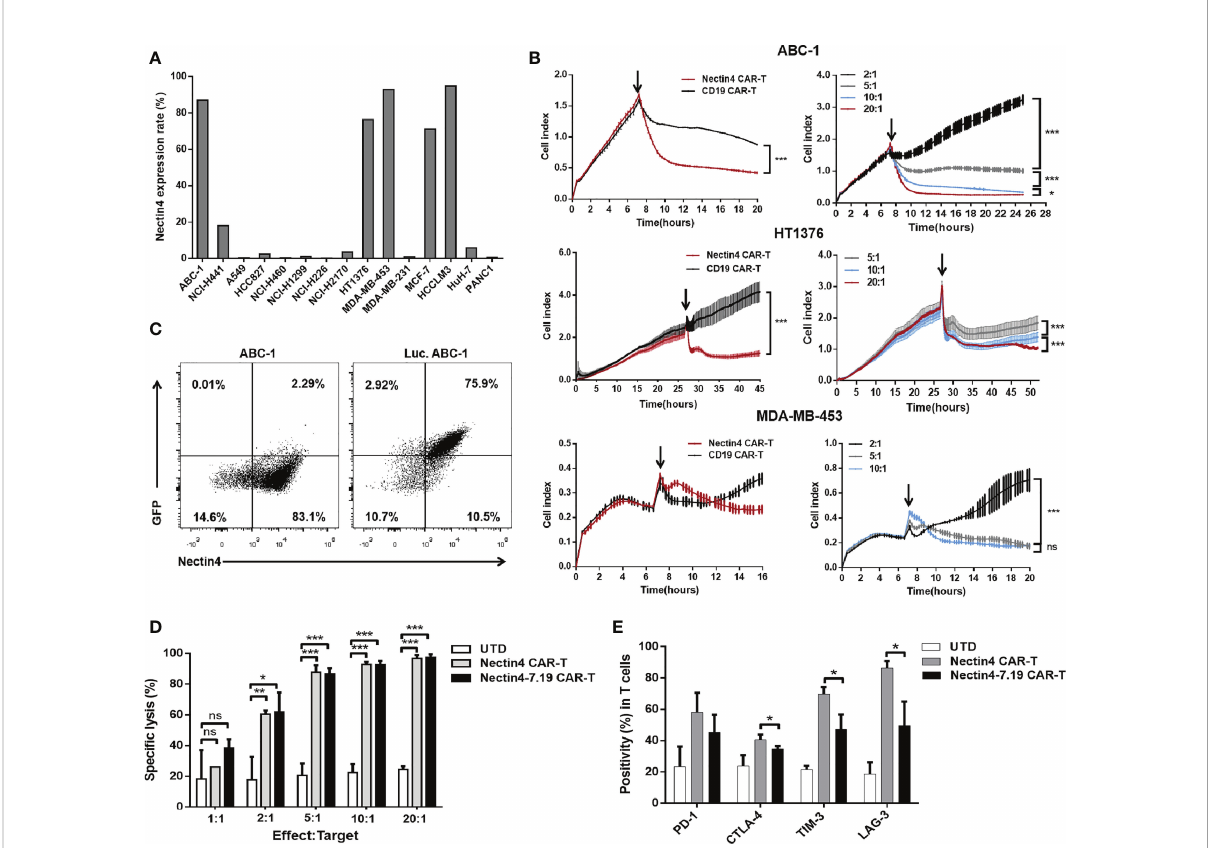
FIGURE 3 Ef fi cient cytotoxicity of Nectin4-7.19 CAR-T cells in vitro . (A) Expression of Nectin4 on a panel of cancer cell lines. (B) Cytotoxicity of Nectin4 CAR-T cells against ABC-1, HT1376, and MDA-MB-453 cells was detected by xCELLigence RTCA label-free technology. The left panel compares the cytotoxicity between Nectin4 CAR-T and CD19 CAR-T cells against target cells at an Effect/Target ratio of 10:1; the right panel shows the killing ef fi cacy of Nectin4 CAR-T cells at different Effect/Target ratios. Arrows refer to the addition of CAR-T cells. The y -axis is the normalized cell index generated by the RTCA software and displayed in real time to re fl ect the vitality of tumor cells. The x -axis is the time of cell culture in hours. (C) Nectin4 and GFP expression in Luc. ABC-1 cells transfected with lentivirus encoding the Luciferase-T2A-GFP gene. (D) Quanti fi ed data on the speci fi c lytic levels of Nectin4 CAR-T and Nectin4-7.19 CAR-T cells against Luc. ABC-1 cells were assessed by luciferase bio-luminescence technique at different Effect/Target ratios in vitro . UTD served as a negative control. (E) Expression level of immune checkpoints was detected by fl ow cytometry after co-culture of Nectin4 CAR-T or Nectin4-7.19 CAR-T cells with ABC-1 cells at an Effect/Target ratio of 1:1 for 5 days. Data represent the mean ± SD of three independent experiments; ns, no signi fi cant difference, * p < 0.05, ** p < 0.01, *** p < 0.001, t